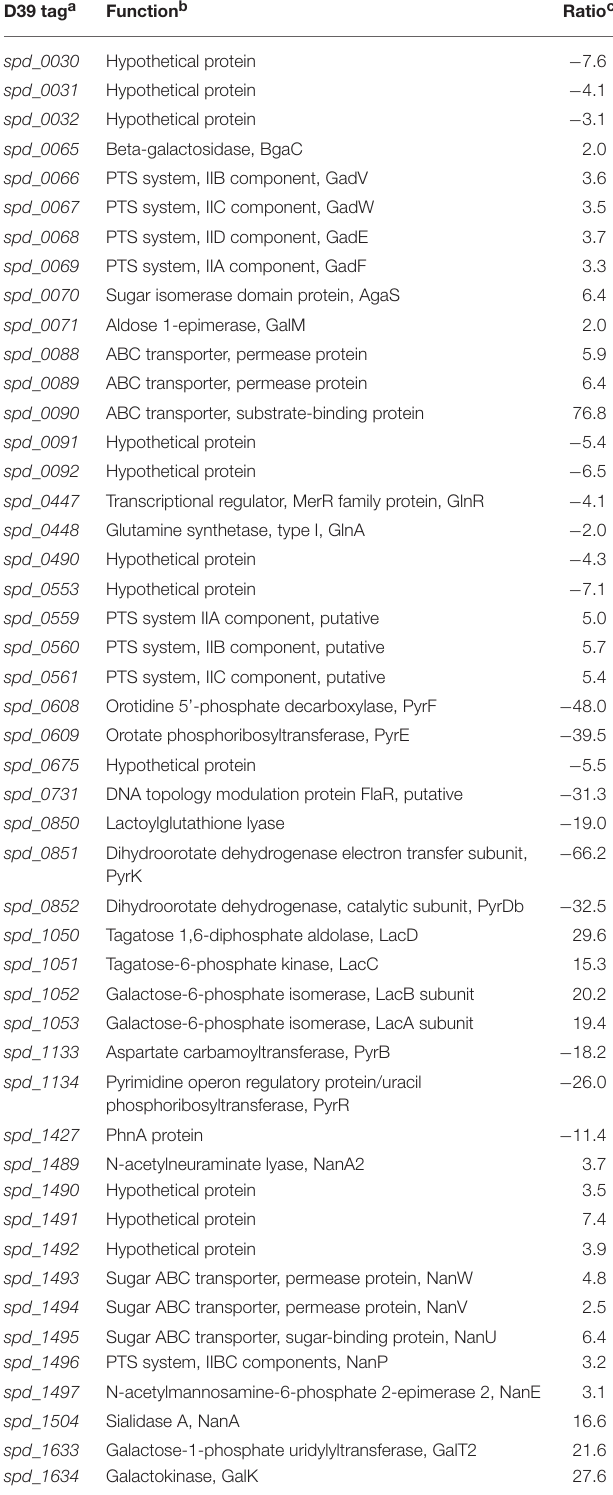
TABLE 3 | Summary of transcriptome comparison of S. pneumoniae D39 wild-type grown in NAGaM17 (0.5% NAGa + M17) to that grown in GM17 (0.5% Glucose +